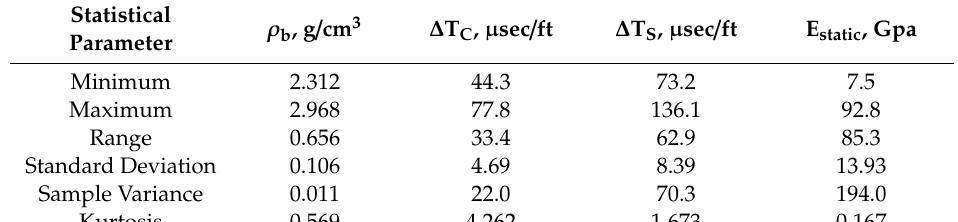
Table 1. Statistics of the training dataset.